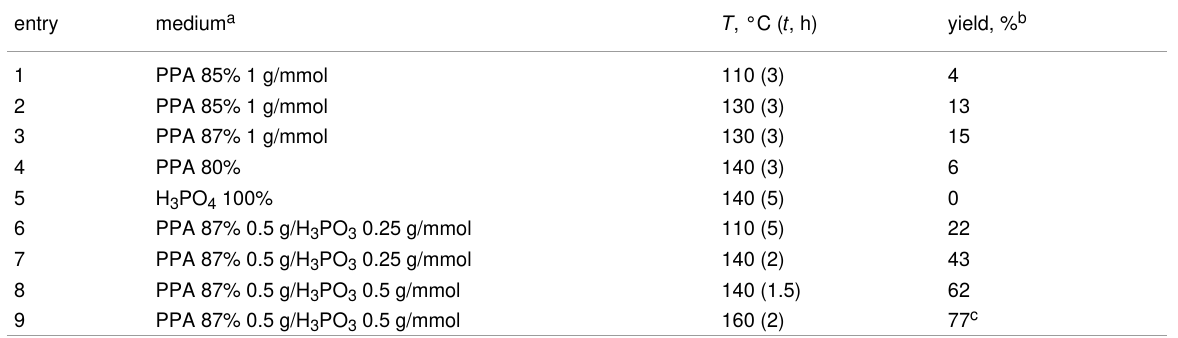
Table 1: Optimization of the reaction conditions for the cyclization of 2-(aminomethyl)pyridine ( 12 ) with nitroethane ( 1a ).